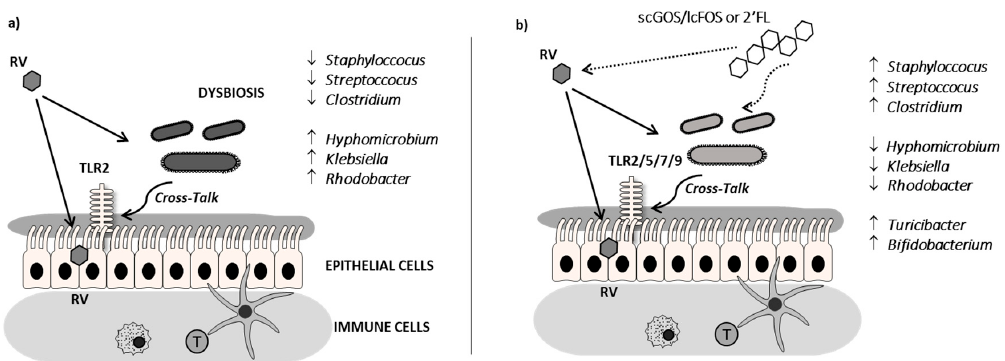
Figure 7. Summary of the effects of the RV and the scGOS/lcFOS and 2’-FL on microbiota composition and crosstalk: ( a ) Microbial imbalance produced by the RV infection in the neonatal rat model in terms of crosstalk alterations and microbiota composition with respect to a noninfected group (REF) and ( b ) Preventive effects of scGOS/lcFOS and 2’-FL on the dysbiosis caused by the RV.